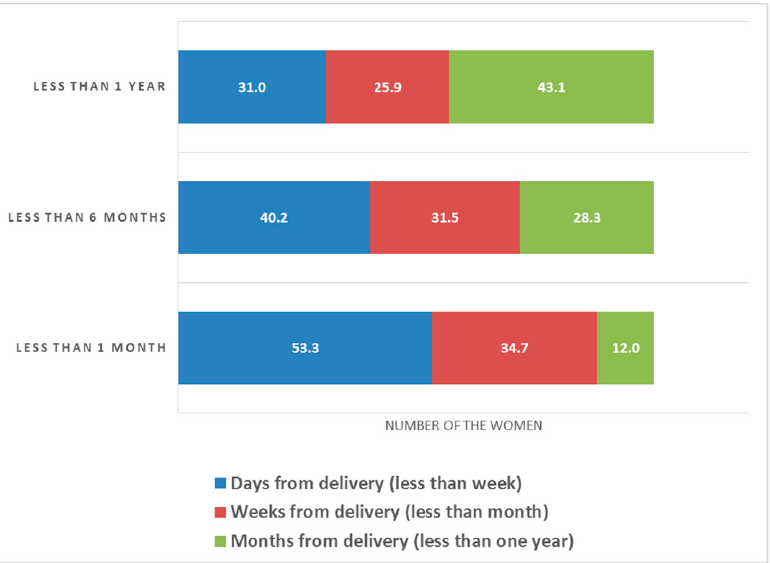
Figure 1. Association between the onset of symptoms and duration of depression symptoms.